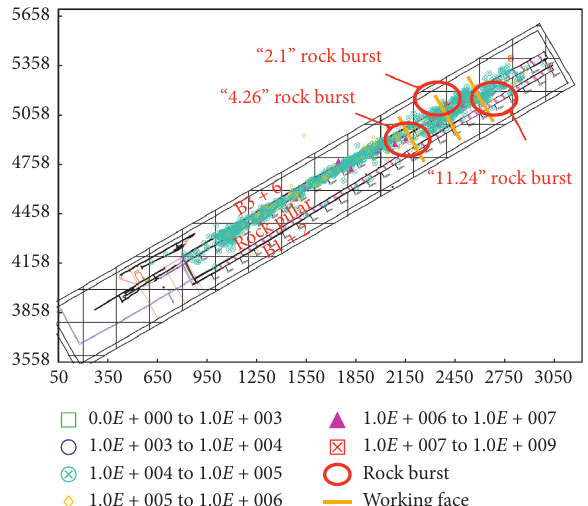
Figure 5: The distribution map of MS events with energy exceeding 1 × 10 3 J in No. B 3 +6 coal seam + 450 horizontal working face WCM during 2016/06/06–2017/12/28.